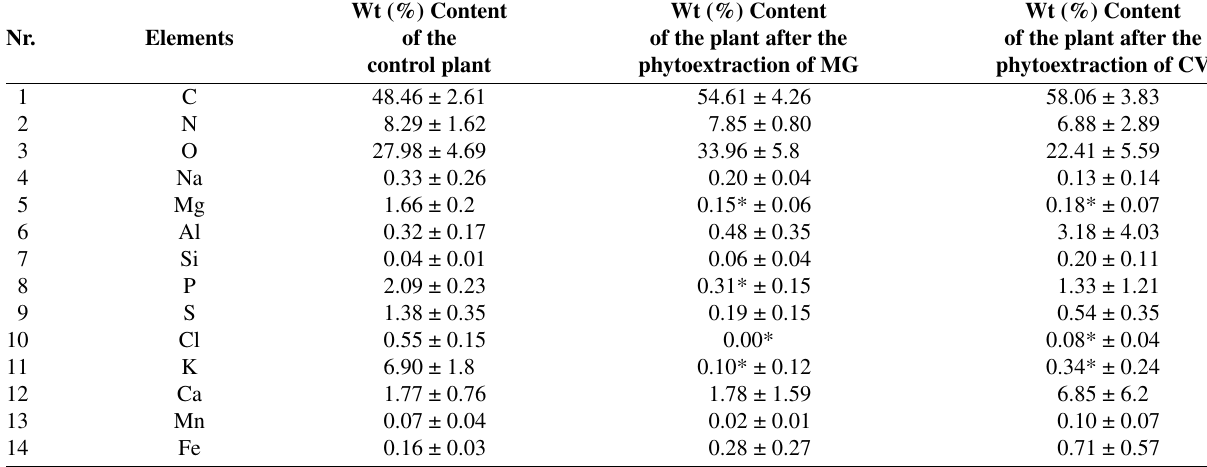
Table 4. EDX analysis of the Lemna minor control and the aquatic plant after the phytoremediation experiments with triphenylmethane dyes; C 100 mg/L, V = 250 mL, initial pH = 3.5 (MG)/3.8 (CV), T = 23 ± 2 °C, until 12 days; values mean ± standard deviations (n = 3), *significant dif- ference at P <